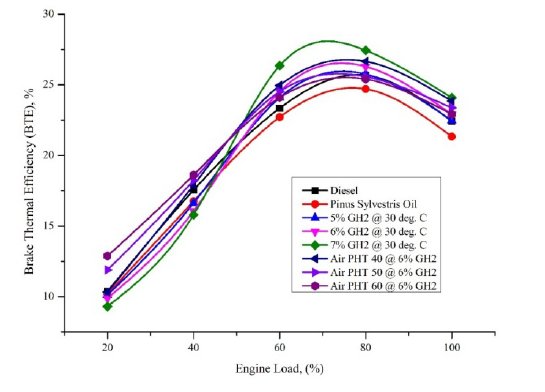
Figure 3. BTE Vs Engine Load